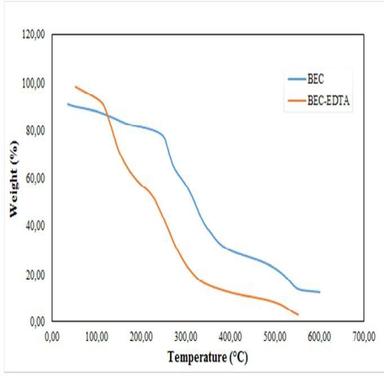
TGA of BEC and BEC-EDTA